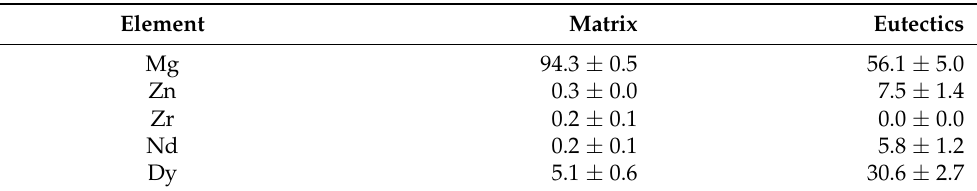
Table 4. Chemical composition of the different phases found on average in reference platelets in wt.% with indication of the standard deviation